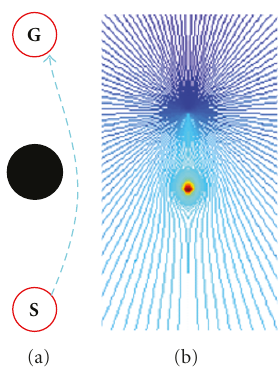
Figure 2: G is the goal, S is the starting point, and the solid circle is an obstacle. (a) Obstacle avoidance. (b) Stream